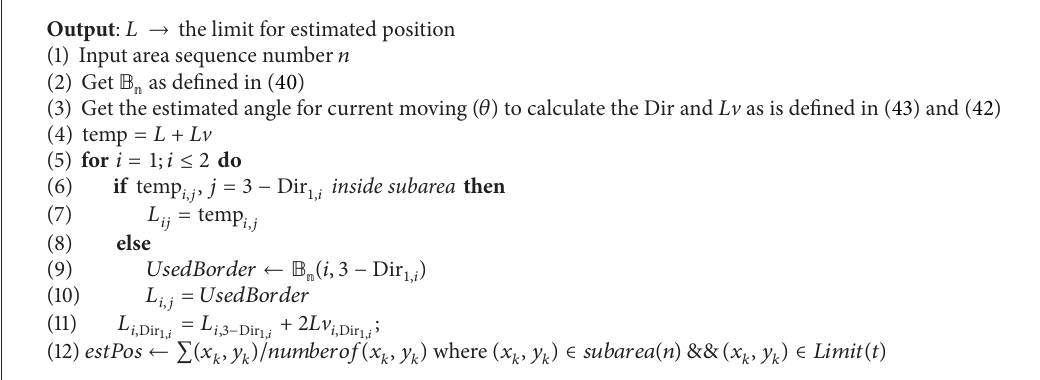
Algorithm 1: Correction at boundary crossing.